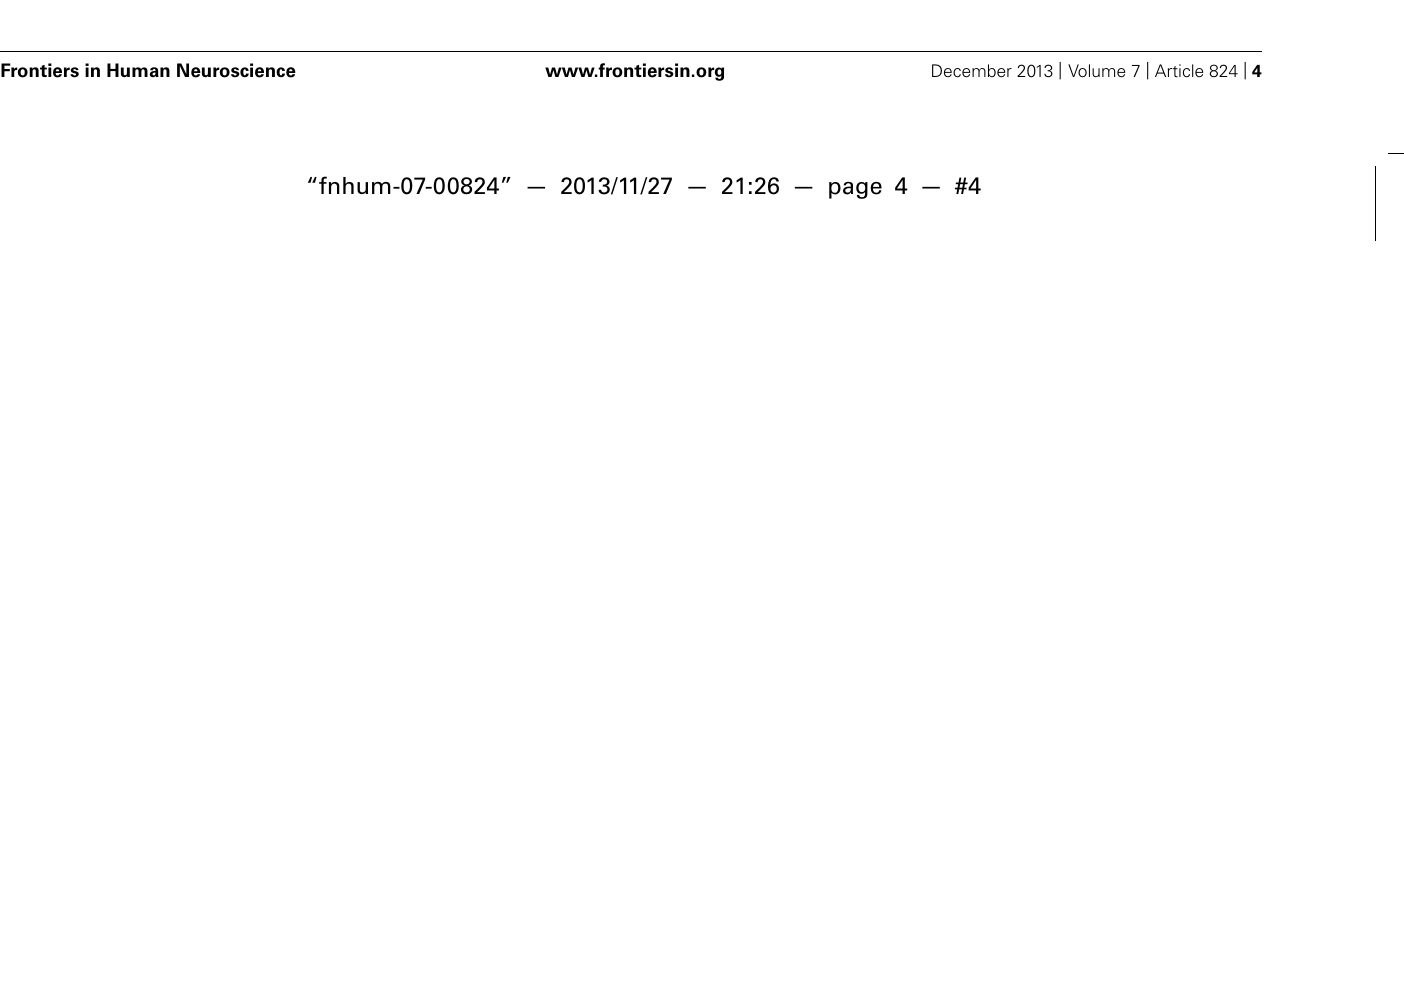
p = 0.11, MSE = 0.247, η 2p = 0.02. In contrast to the RAT find- ings, the flexibility effect was not modulated by group, F < 1, and the same was true for originality, F (2,184) = 1.20, p = 0.302, MSE = 0.320, η 2p = 0.01, fluency, F < 1, and elaboration, F (2,184) = 1.07, p = 0.346, MSE = 2.838, η 2p = 0.01. There was also no indication of any three-way interaction, p ’s >